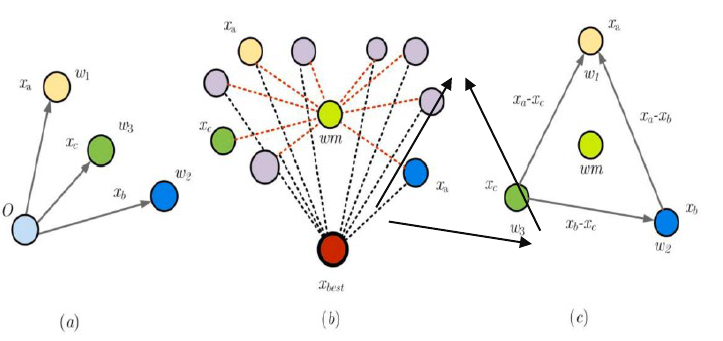
Figure 5. Mother wavelet.